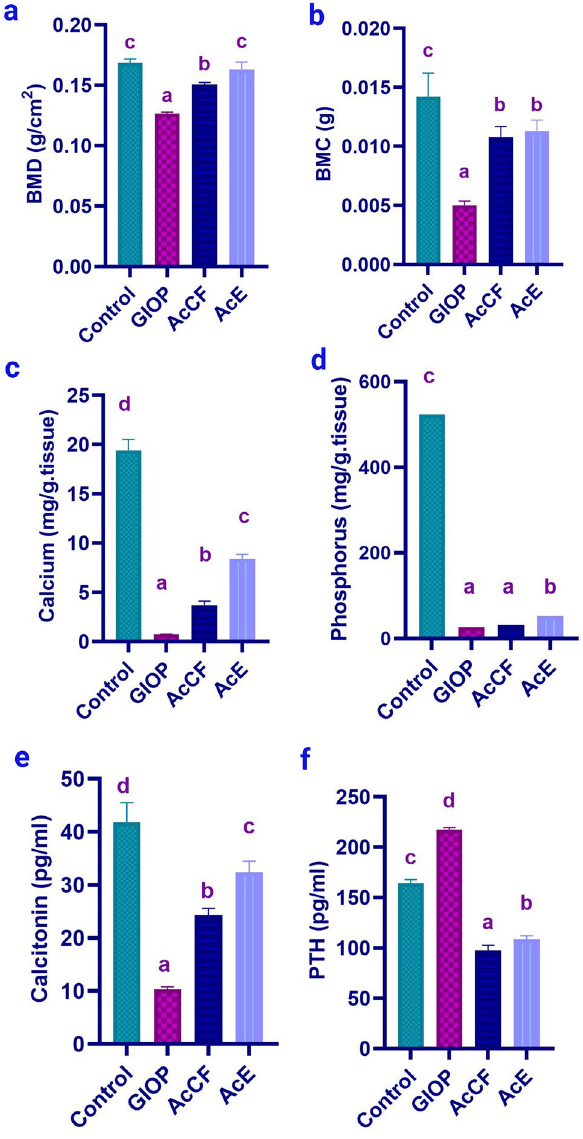
Figure 2. ( a ) Bone mineral density (BMD) assessed by DEXA, ( b) Bone mineral content (BMC) assessed by DEXA, ( c ) Quantitative analysis of calcium in bone homogenate, ( d ) Quantitative analysis of phosphorus in bone homogenate. e Serum levels of calcitonin assessed by ELISA. ( f ) Serum levels of parathyroid hormone (PTH) assessed by ELISA. Data are expressed as mean ± SD (n = 6 per group). Each value not sharing a common letter superscript is significantly different ( P < 0.05), where (a) is the lowest value and ( d) is the highest